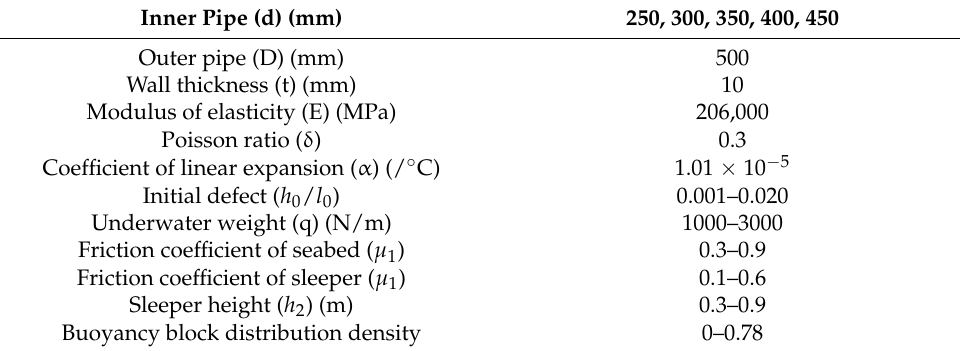
Table 2. Range of